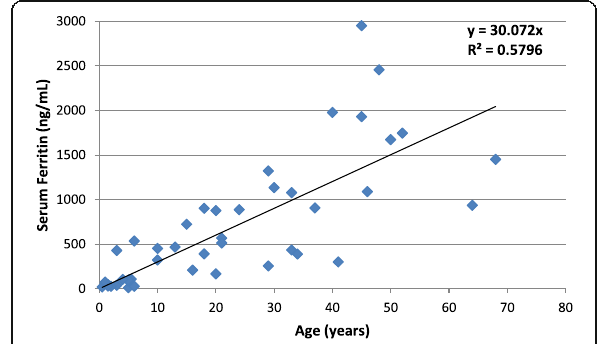
Fig. 1 Correlation of serum ferritin with the age of HbH disease patients